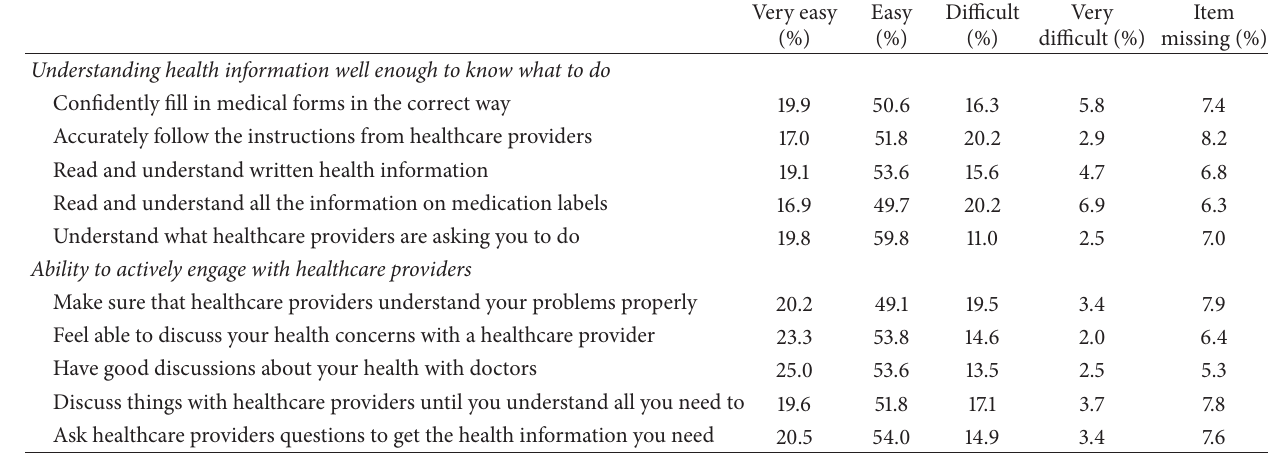
Table 2: Response distribution and missing values for each item of the two health literacy